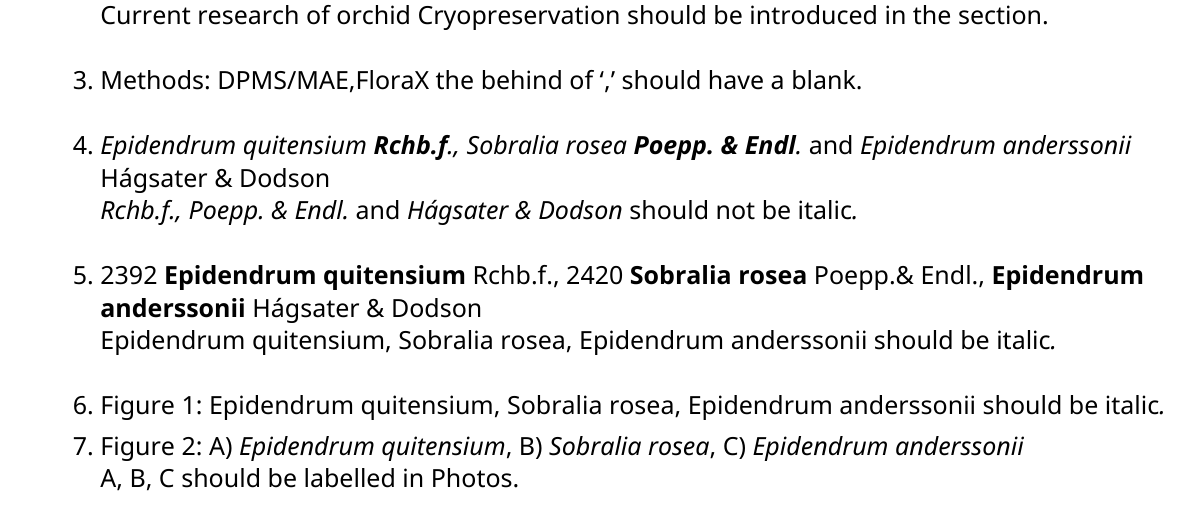
Figure 1: Epidendrum quitensium, Sobralia rosea, Epidendrum anderssonii should be italic . 6. Figure 2: A) Epidendrum quitensium , B) Sobralia rosea , C) Epidendrum anderssonii A, B, C should be labelled in